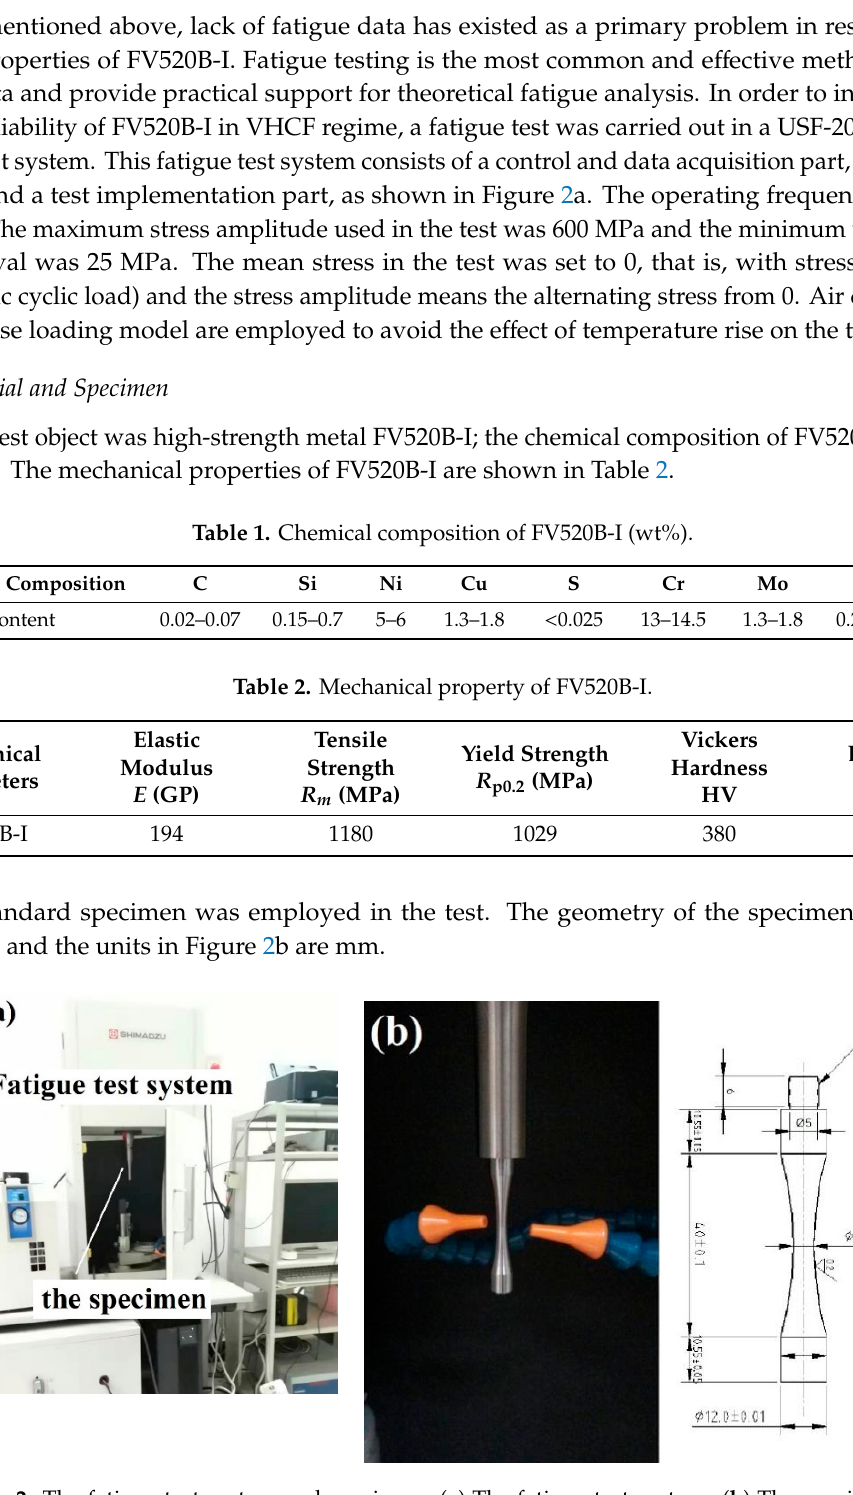
Figure 2. The fatigue test system and specimen. ( a ) The fatigue test system. ( b ) The specimen and its its dimensions.